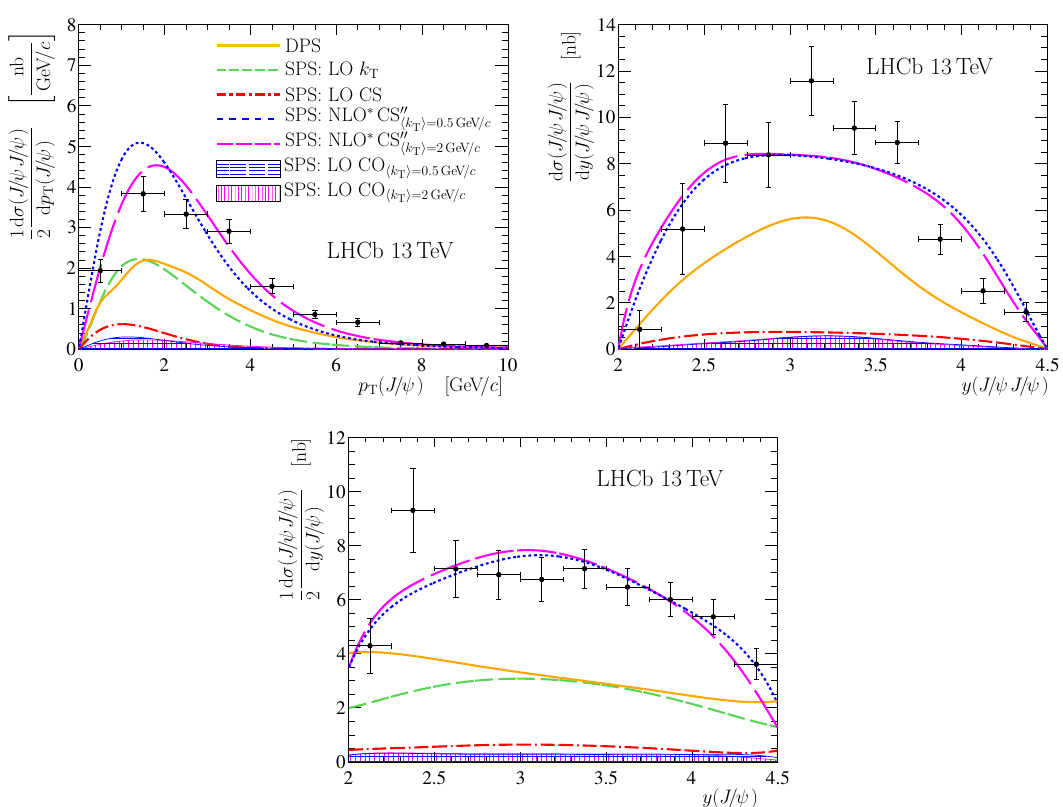
Figure 3. Comparisons between measurements and theoretical predictions for the di(cid:11)erential cross-sections as functions of (top left) p T ( J= ), (top right) y ( J= J= ) and (bottom) y ( J= ). The (black) points with error bars represent the